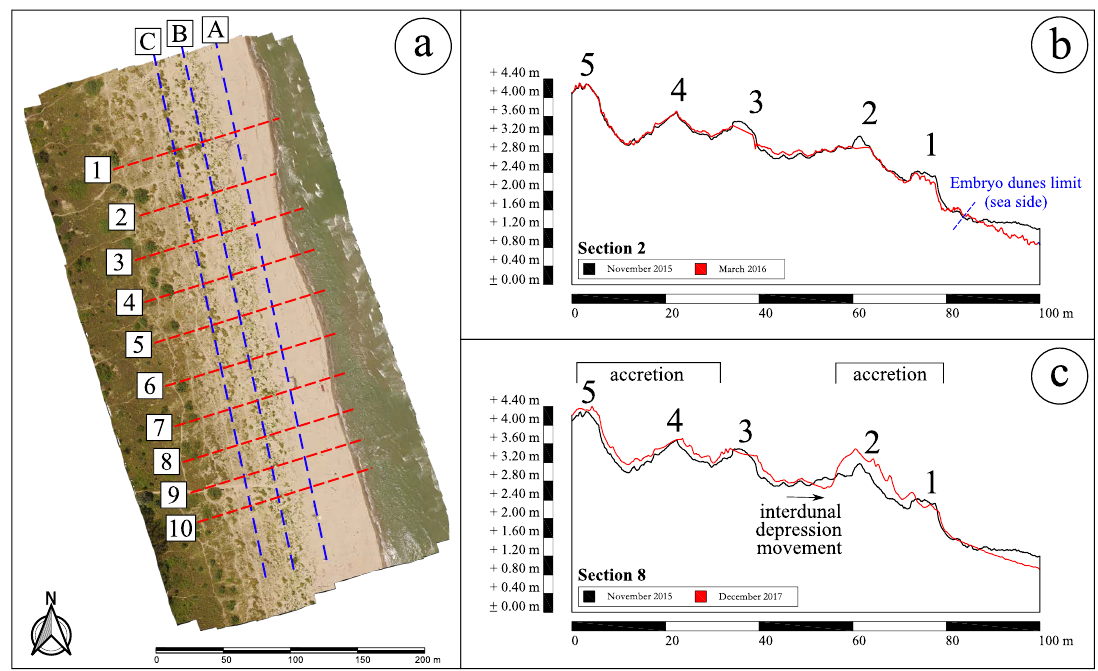
Figure 13. ( a ) Location of the cross and longitudinal sections; ( b ) Detection of the morphological evolution of dunes during first winter season by the comparison of the profiles of November 2015 (black) and March 2016 (red) on cross-section 2; ( c ) Detection of the morphological evolution of dunes over two years by the comparison of the profiles of November 2015 (black) and December 2017 (red) on cross-section